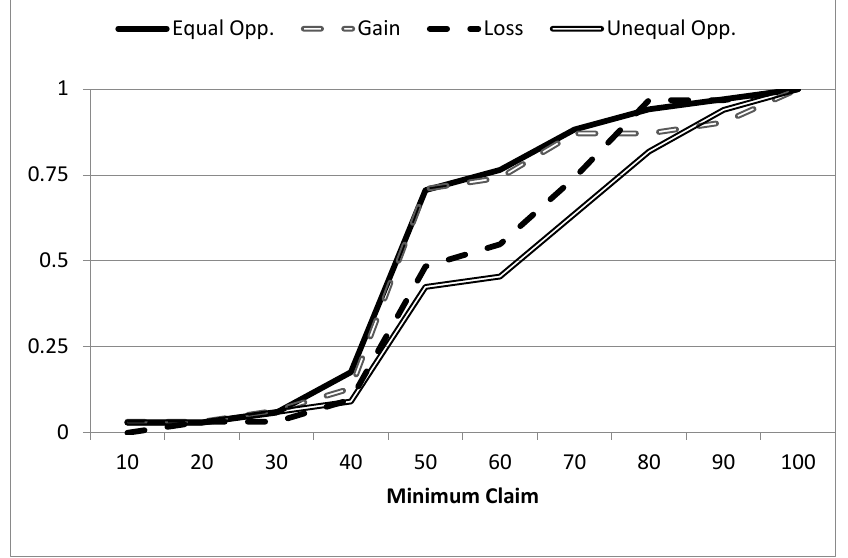
Figure 1. Cumulative distribution of minimum claims of low contributors across the treatments.